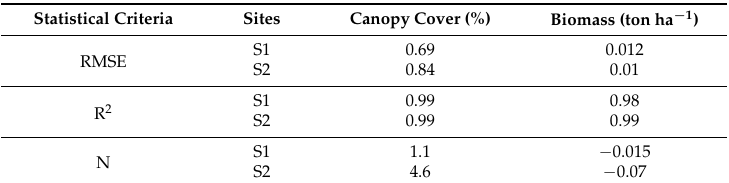
Table 6. Statistical evaluation of model simulation.